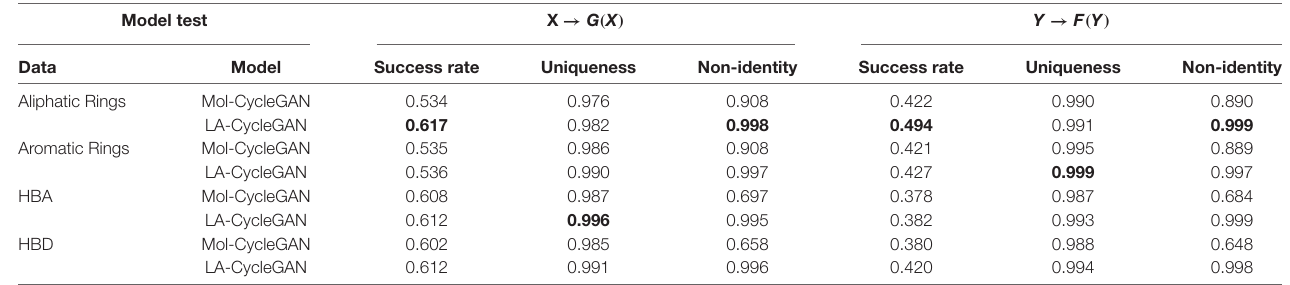
TABLE 3 | Structure conversion assessment of generated molecules. Model test